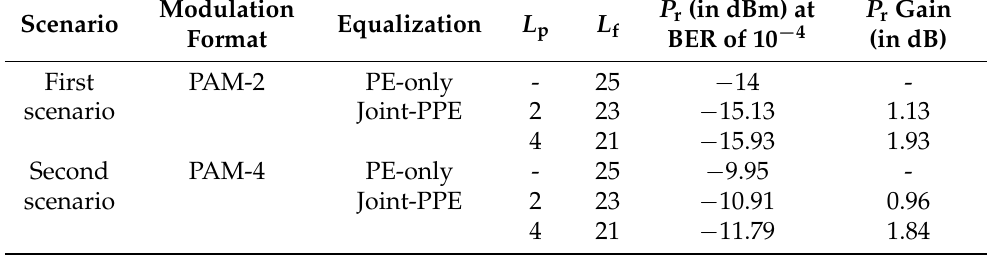
Table 3. Measured optical received power P r gain of the ( 2 using a 100m long MMF channel at f T = 2.5GHz.